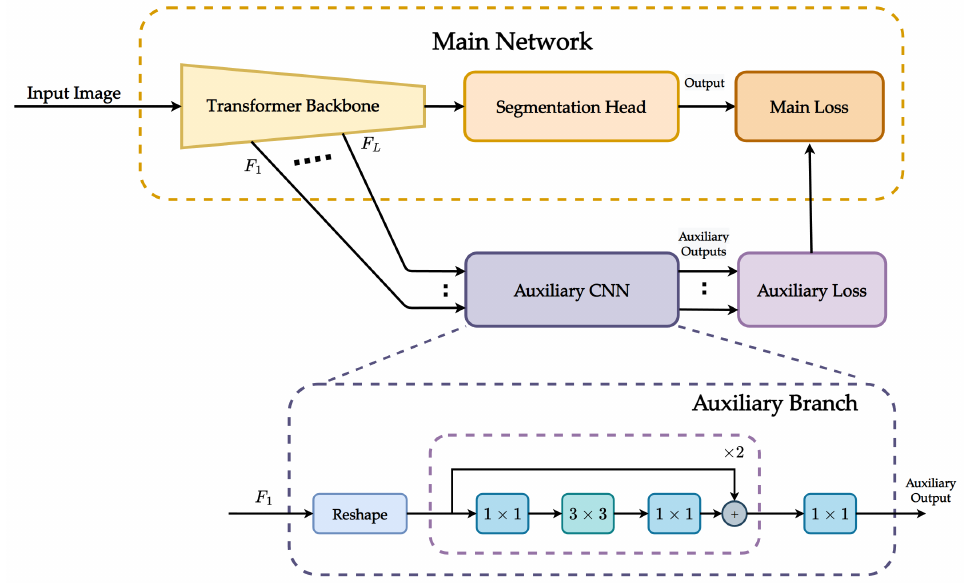
Figure 1. Architecture overview. The proposed method is instantiated on top of Mask2Former [11], which uses Swin Transformer [42] as the backbone network to extract feature embeddings { F 1 , . . . , F L } . The proposed auxiliary CNN consists of several simple convolutional layers to learn more accurate local features by using the feature embedding produced by the Transformer backbone as input. An auxiliary loss is used along with the main loss to compute the total loss for segmentation. The auxiliary CNN is used for training only and will be removed at